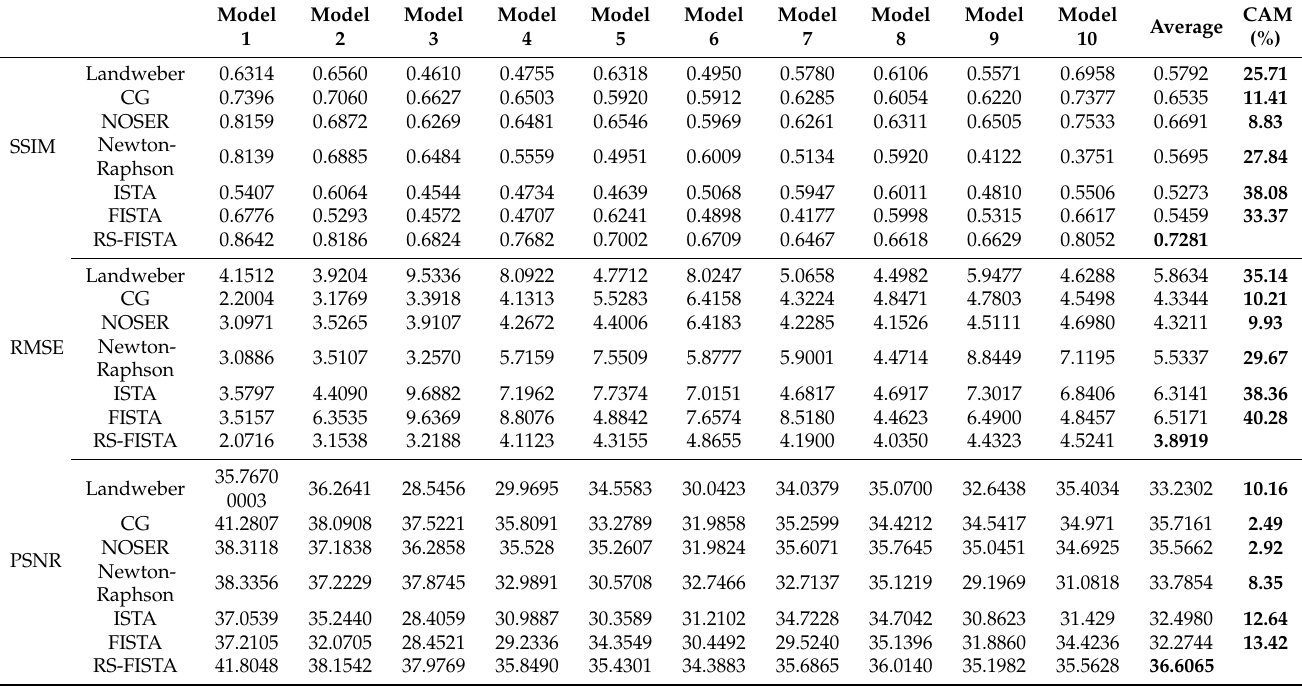
Table 1. Imaging evaluation metrics of simulation experiments of different